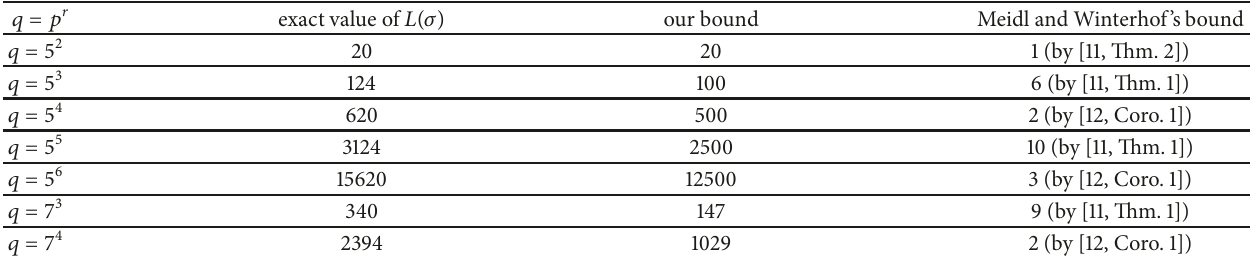
Table 1: Comparison of bounds on 𝐿(𝜎)